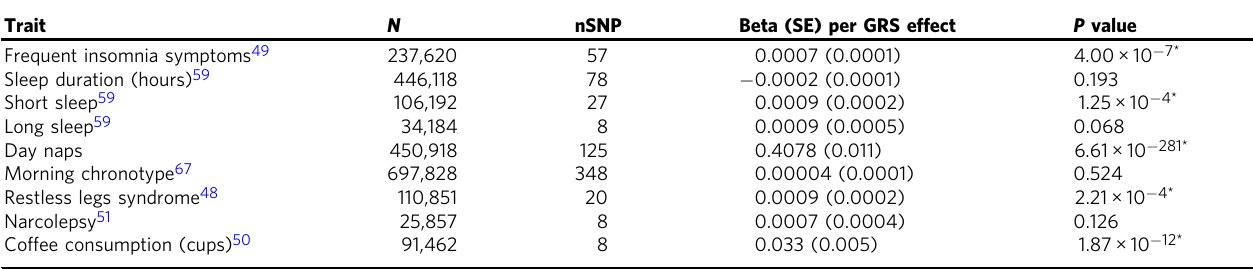
Table 2 Association between weighted genetic risk scores (GRS) of signi fi cant SNPs ( P < 5 × 10 − 8 ) for other sleep behavioral traits and sleep disorders with self-reported daytime sleepiness phenotype in UK Biobank Trait